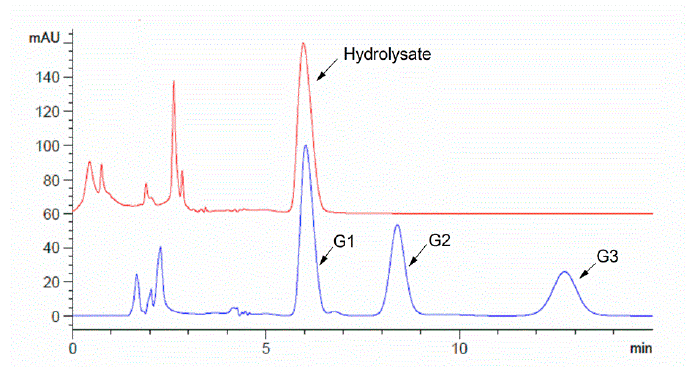
Figure 7. HPLC analysis of the hydrolyzed products of chitin (G1, G2 and G3 represent the standard sample of GlcNAc, Chitobiose and Chitotriose.